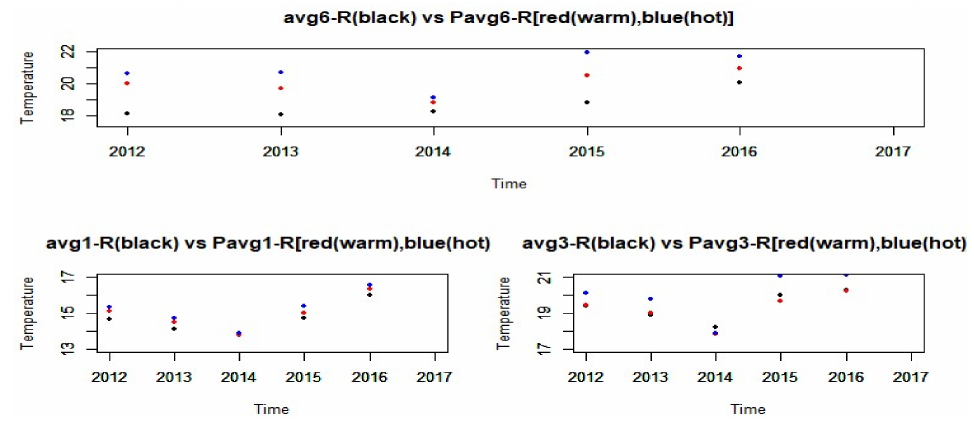
Figure 35. RCP 8.5 hot model (MIROC-ESM-CHEM) and RCP 8.5 warm model (IPSL-CM5A-MR) predictions for the period 2012–2017 (recorded water level), temperature in ◦